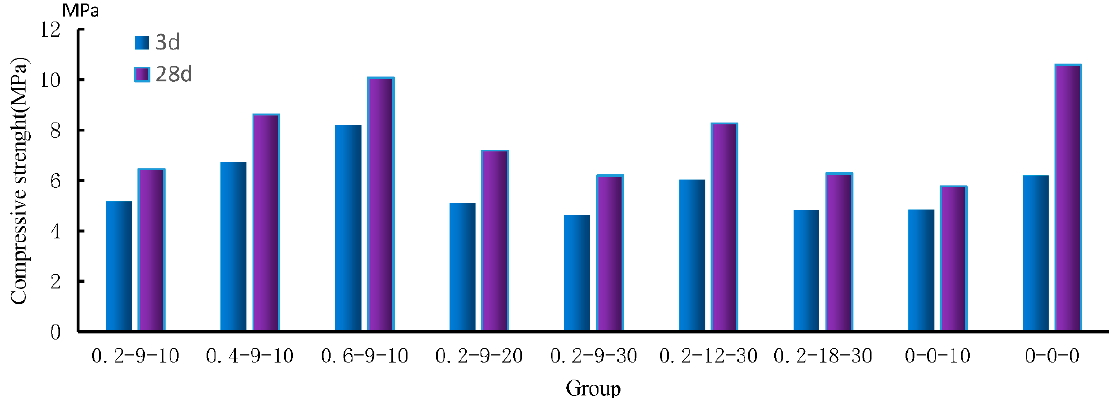
Figure 2. Diagram of multi ‐ age compressive strength variation in each group.